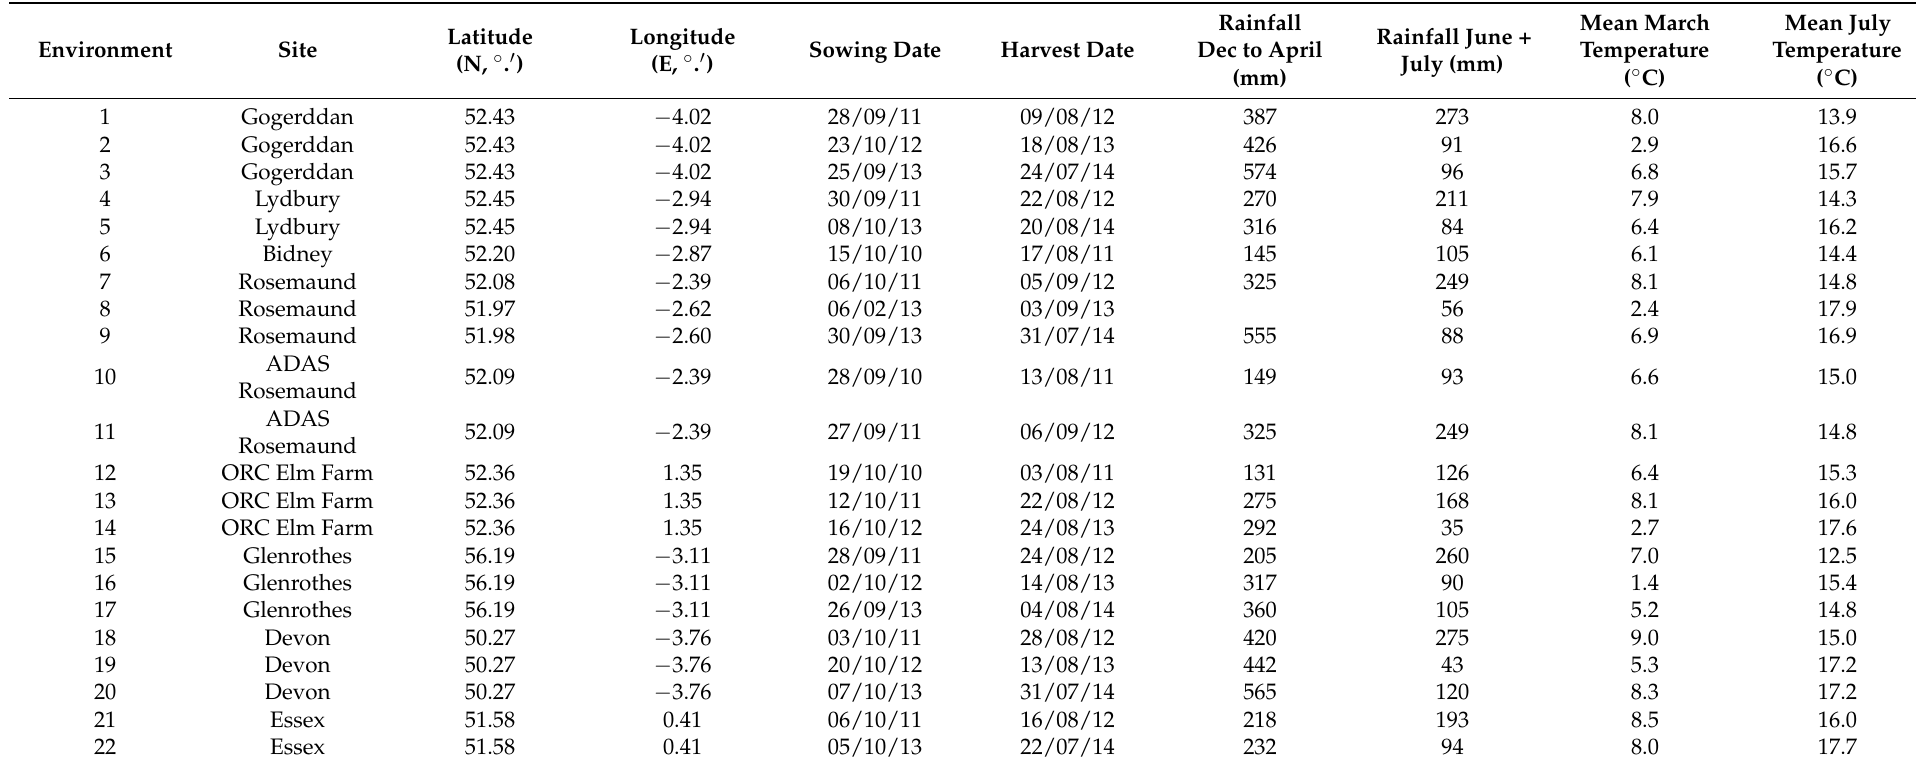
Table 1. Field sites, sowing and harvest dates of the winter oat trials grown across the UK over four harvest years (2011–2014) and environmental conditions during those trials including total rainfall (mm) in the periods specified and mean air temperatures for March and July.